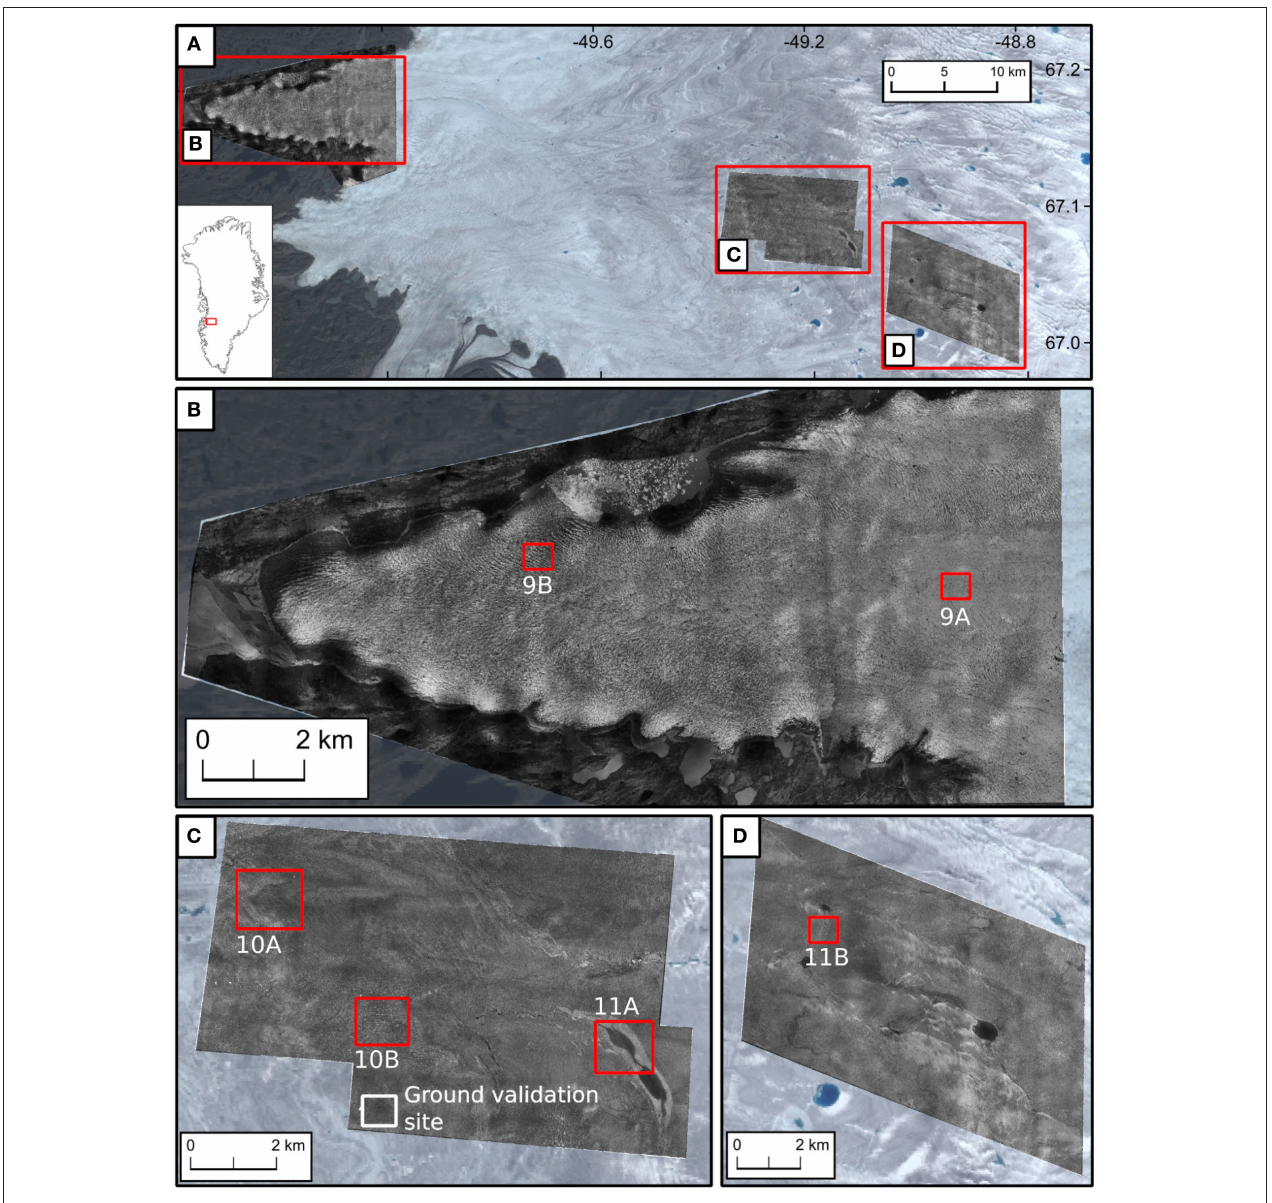
FIGURE 8 | (A) Map showing locations of the three high resolution albedo products (UAV10A1) in West Greenland. (B) UAV10A1-Isunguata, a land-terminating outlet glacier. (C) UAV10A1-S6, an ablation area site at around 1,100 m a.s.l. (D) UAV10A1-Behar, an ablation area site between 1,200 to 1,350m a.s.l. which encompasses the catchment of large supraglacial river informally known as Rio Behar.